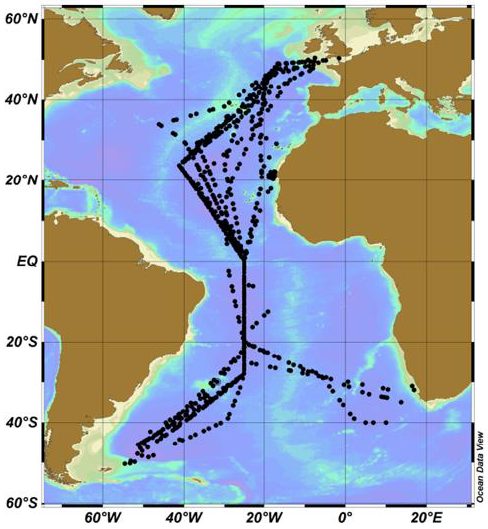
Figure 1. Transects of the 13 AMT cruises (704 stations) used to create the empirical model to predict the abundance of Prochlorococcus cells.